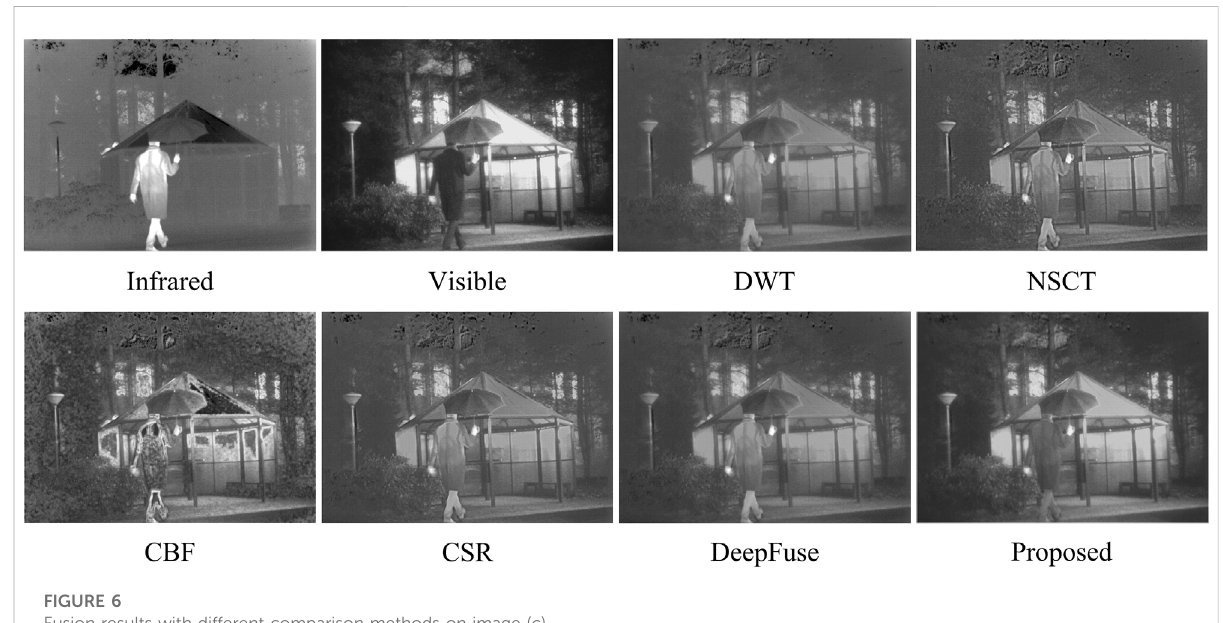
FIGURE 6 Fusion results with different comparison methods on image (c).